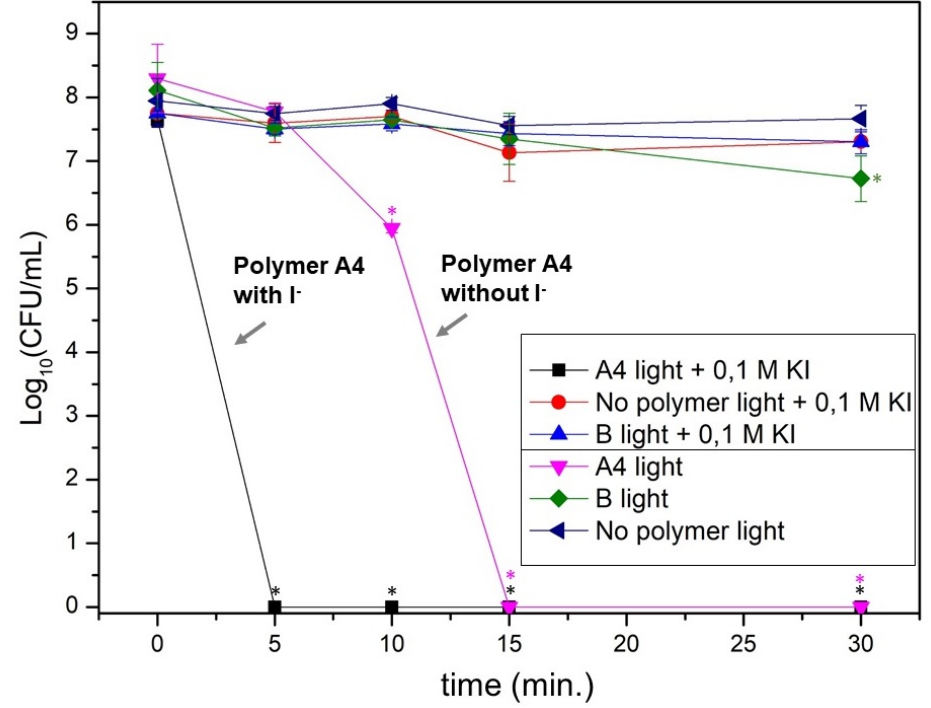
Figure 8. Photodynamic inactivation assays against P. aeruginosa with polymers A4 or B , with and without iodide anion and with or without light (see legend for details). Asterisks (*) indicate significant differences with respect to value at time 0 min for each aPDI condition ( p ≤ 0.01).